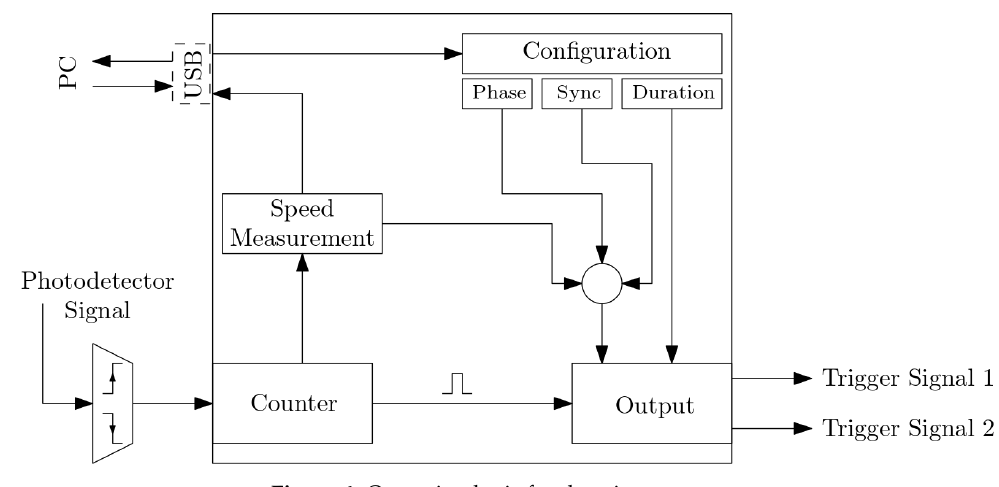
Figure 4. Operation logic for the trigger